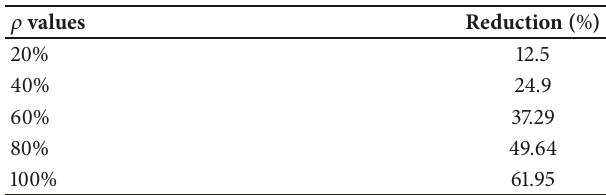
Figure 5: Sensitivity analysis on the cumulative number of newly infected individuals by varying 𝜉 , i.e., the probability of effective surveillance in blood transfusions. Table 2: Percentage reductions due to variation only in parameter 𝜌 – the proportion of treatment in infected newborn.